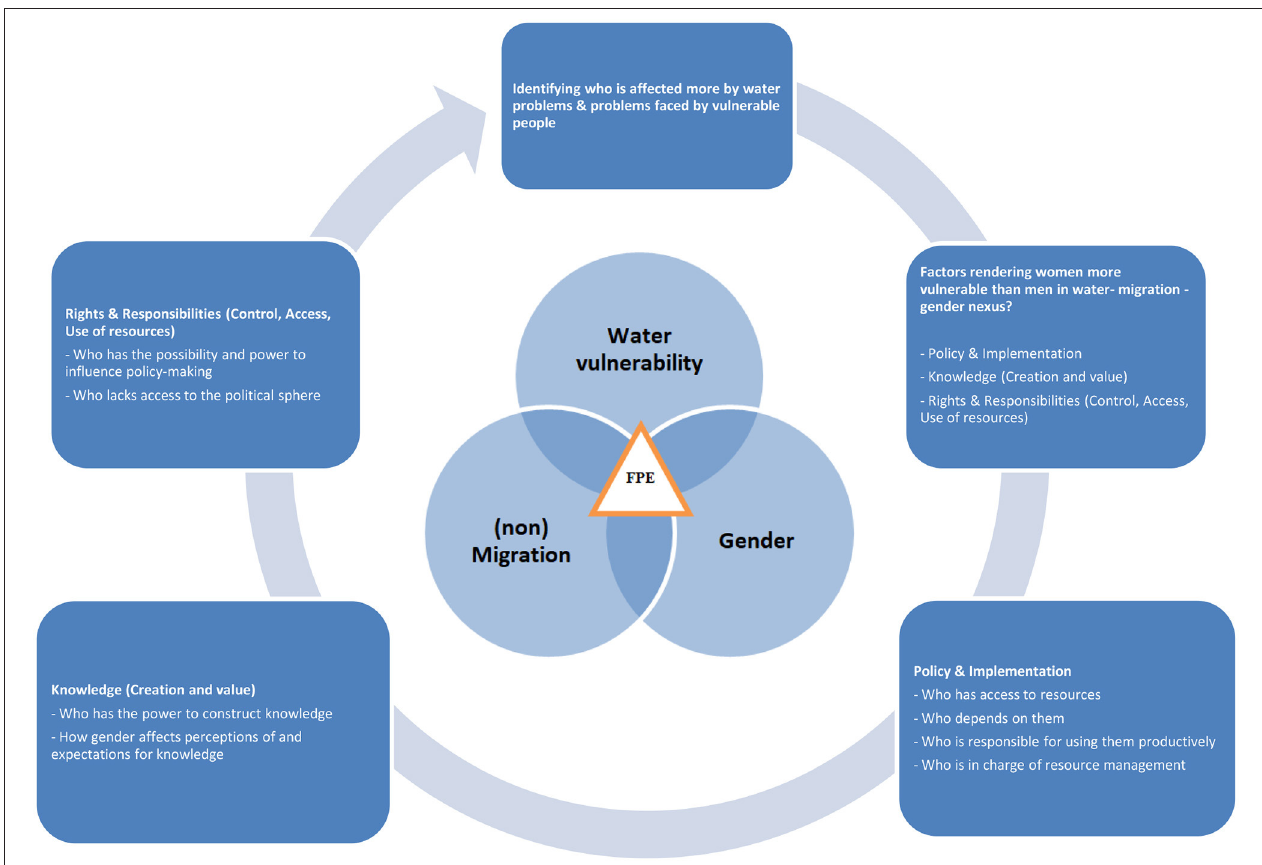
FIGURE 1 | The conceptual framework: integrated governance strategies for water-migration-gender nexus through feminist political ecology (FPE). Source: author’s illustration based on Ylipaa et al.